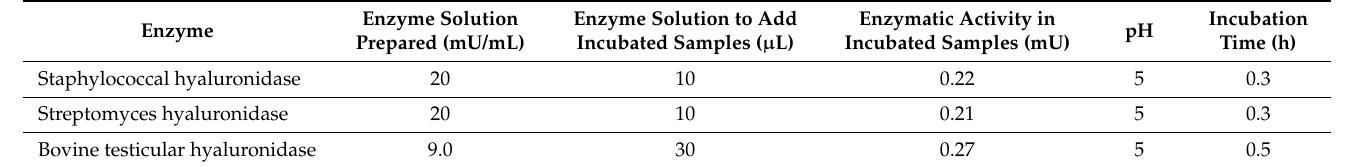
Table 1. Enzymatic activities of staphylococcal hyaluronidase turbidity assay.